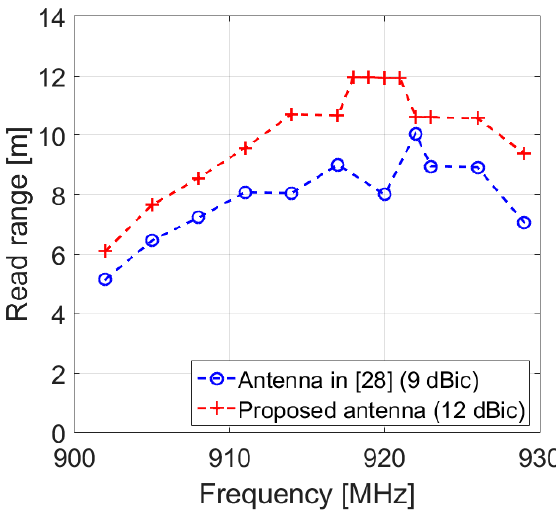
Figure 10. Experimental read range results with the proposed antenna and the antenna in [28] as a function of the frequency for P EIRP = 36 dBm.